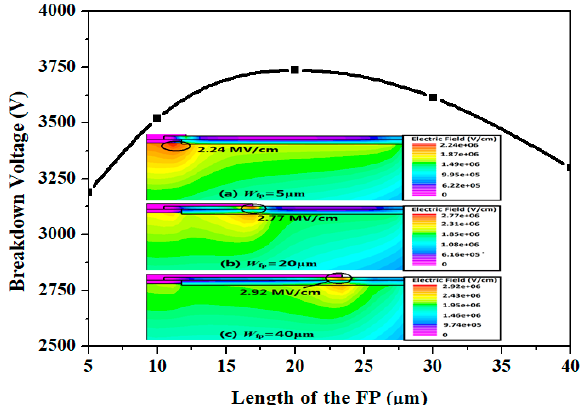
Figure 6. Simulated BV versus FP length ( W fp ) for the Step-DZ-JTE with FP optimization.